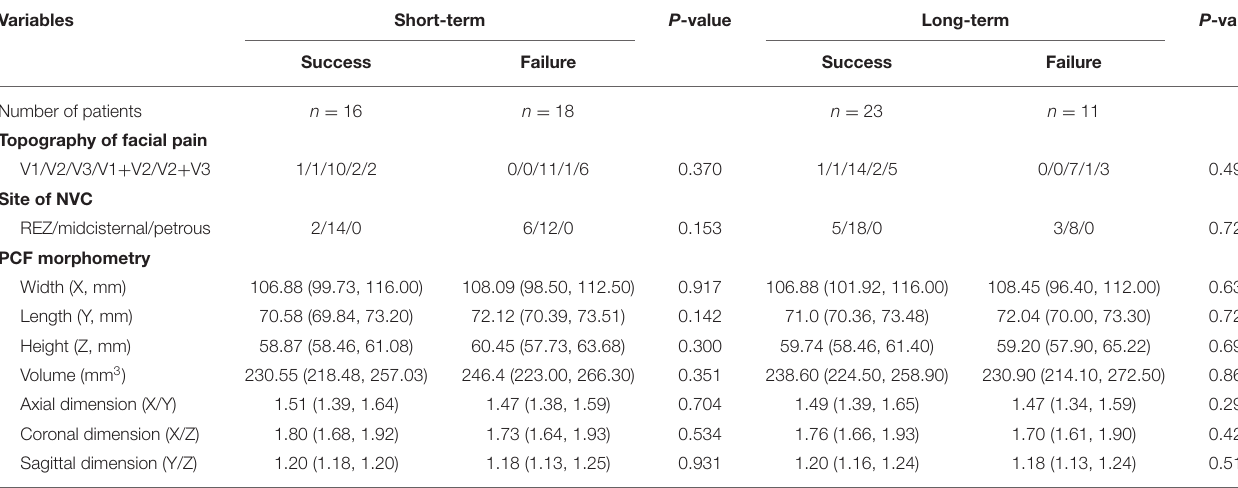
TABLE 5 | Outcomes after MVD for classic TN patients caused by sole venous